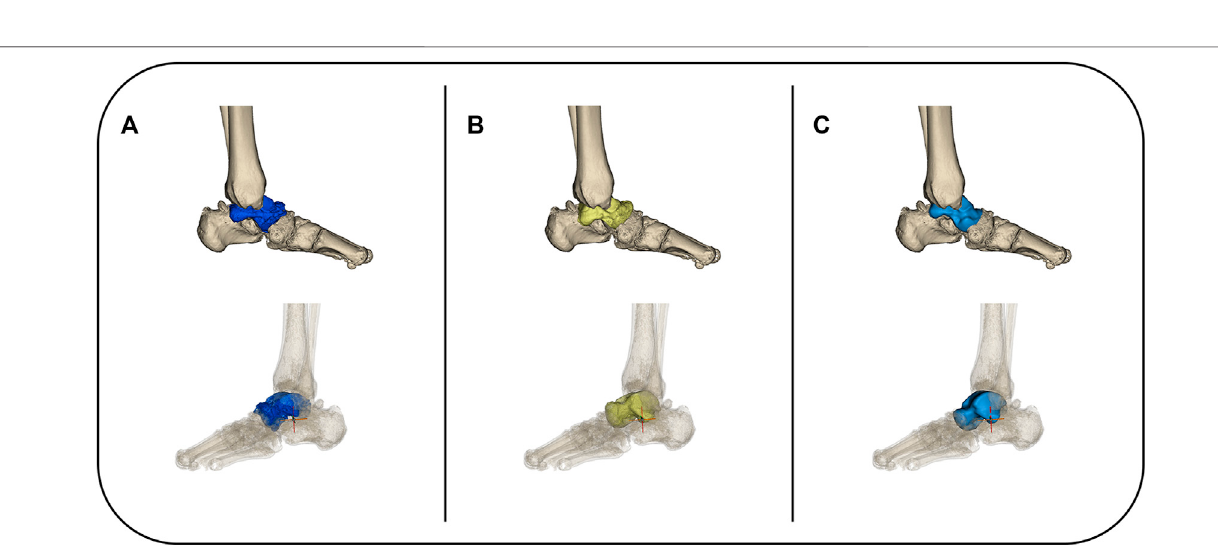
Frontiers in Bioengineering and Biotechnology |